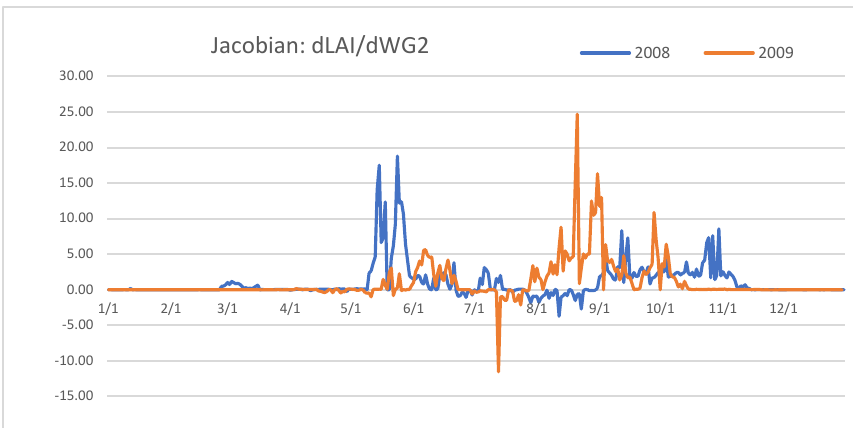
Figure 4. Jacobian values of dLAI/dWG2 for 2008 and 2009.